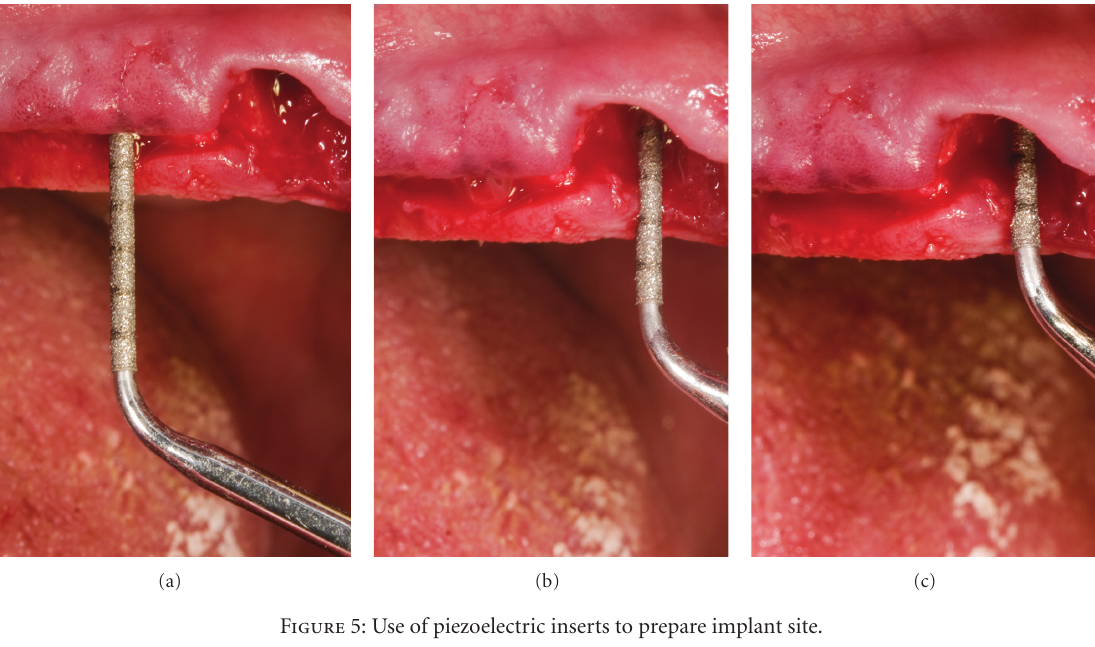
Figure 5: Use of piezoelectric inserts to prepare implant site.